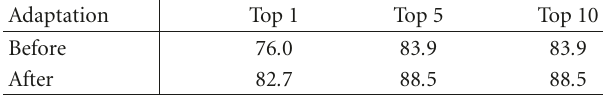
Table 4: Word recognition/error rate [%]. Table 5: Retrieval accuracy [%].